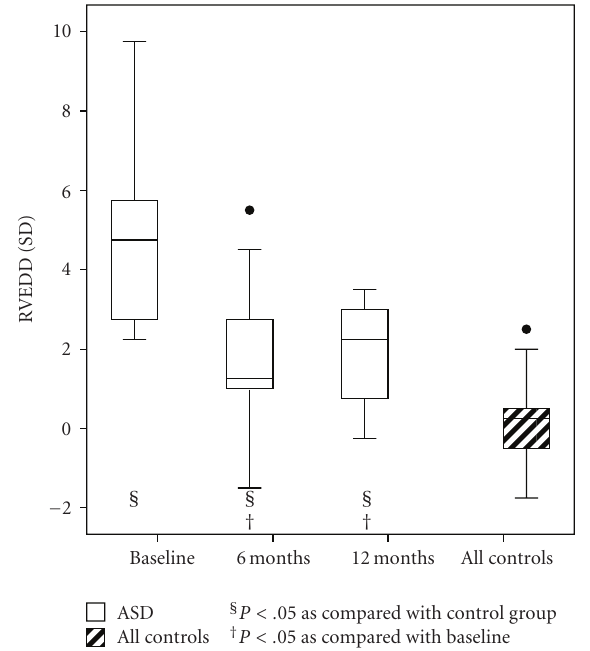
Figure 3: The z -score (SD) of end-diastolic diameter of left ventricle (LVEDD) in patients with patent ductus arteriosus (PDA) and in controls. Whiskers at the top and bottom of each box indicate maximum and minimum; the top and bottom of each box the third and first quartiles; line through the box the median. Solid circles are